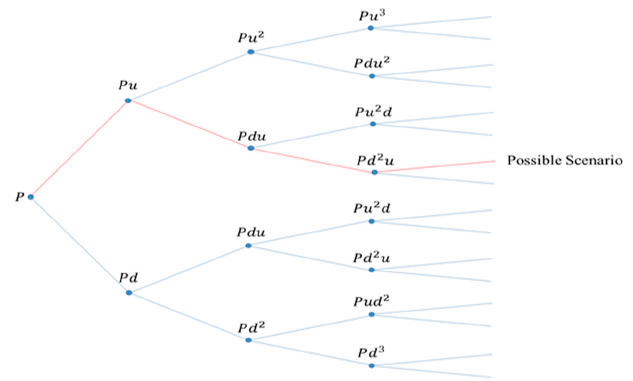
Figure 1. Binomial tree for determination of each possible scenario for crude oil price.